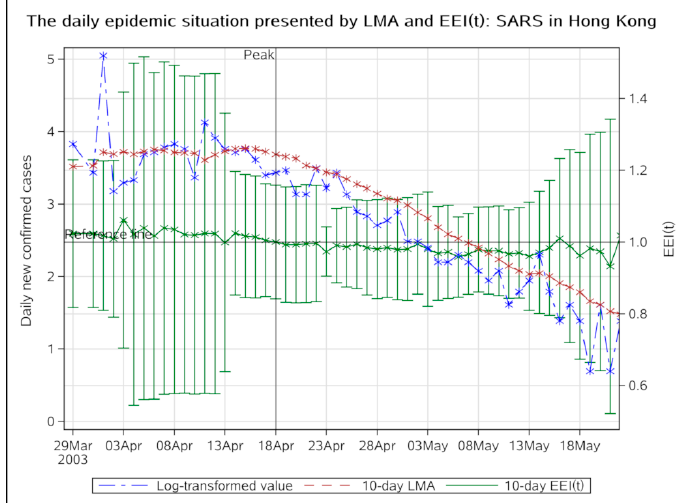
Figure 1. The daily epidemic situation presented by LMA and EEI(t), SARS in Hong Kong, from 29 Mar to 21 May 2003. LMA, moving average of log-transformed daily new cases and EEI(t), epidemic evaluation index